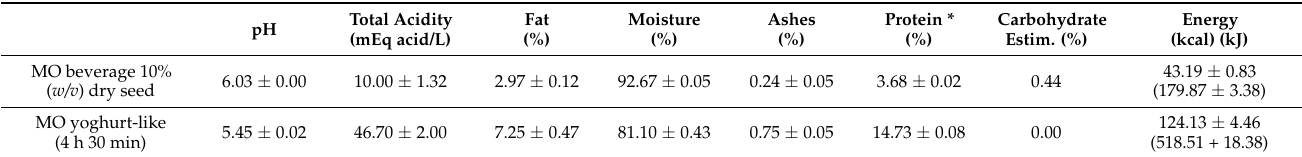
Table 3. Proximal chemical analysis of Moringa oleifera -based beverage (10% w/v ) and yoghurt-like. The percentage of respective parameters are per 100 mL for MO beverage and for 100 g for MO yoghurt-like. Values are represented as mean ± standard deviation ( n = 3). * based on raw seed protein